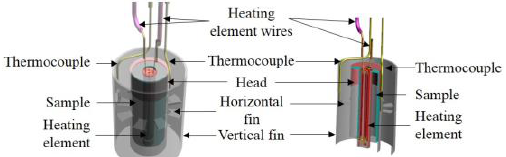
Fig. 1. A 3-D schemes of the first CALORRE calorimetric cell prototype (on the left-hand section) and of an internal view of this cell (on the right- hand section).